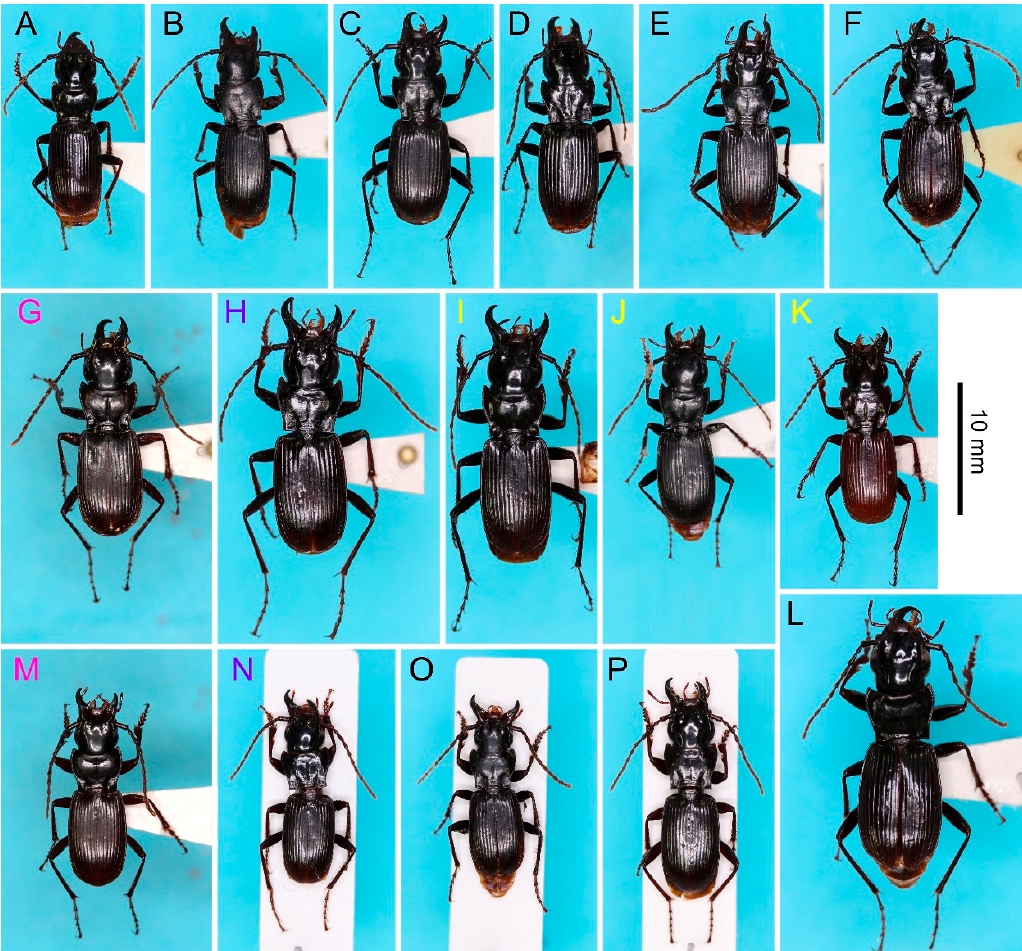
Figure 2. Habitus dorsal view of the macrogenys species group; ( A ), ( B ) P. chokaisanus males from Sakunami ( A ) and Kamihôzawa ( B ); ( C ) P. kurikomasanus male from Yuhama Pass; ( D – I ) P. falcispinus males from Kurosawagawa forest road ( D ), Togawa ( E ), Ôtori ( F ), Miyahisa ( G ), Nukumidaira ( H ), and Mt. Takadateyama ( I ), ( J ) P. takadateyamanus male from Mt. Takadateyama; ( K ) P. adatarasanus male from Mt. Takadateyama; ( L ) P. gassanus male from Goshiki forest road; ( M – N ) P. iwakiensis males from Miyahisa ( M ) and Nukumidaira ( N ); ( O ) P. eboshiyamanus male from Yunosawa; ( P ) P. monolineatus sp. n. holotype male from Aobaminami. Pink, purple, and yellow letters indicate that specimens were obtained at collection sites indicated by these respective colors in Figure 1.